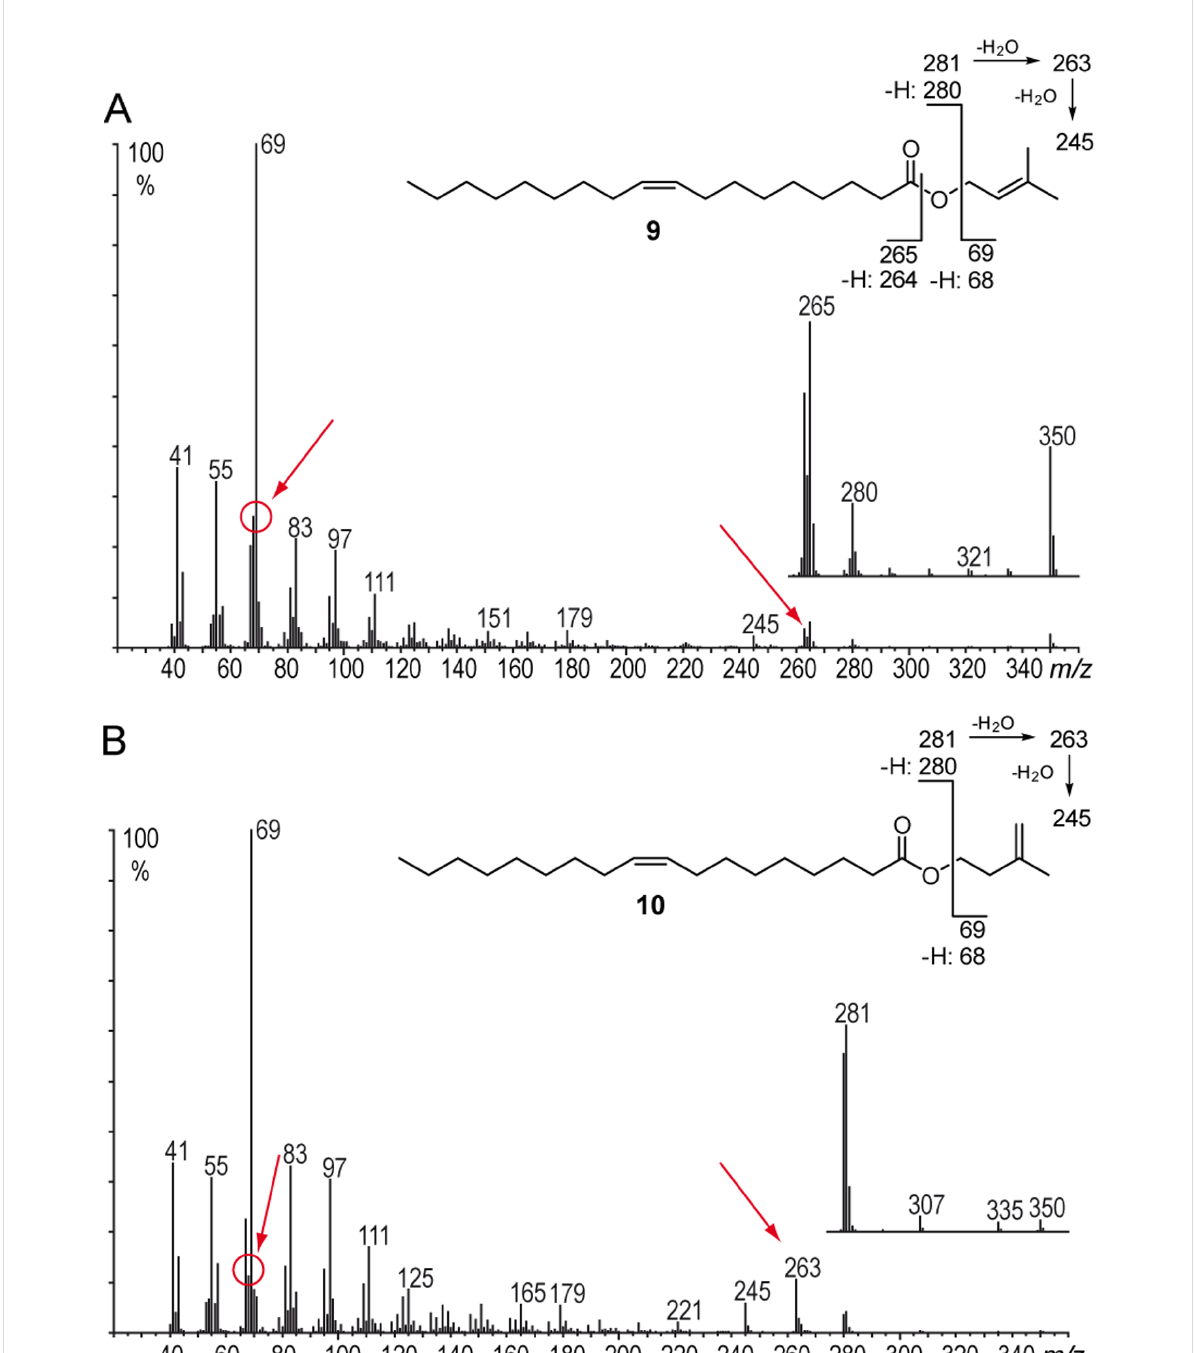
Figure 4: Mass spectra and fragmentation of A: isoprenyl (3-methyl-3-butenyl) 9-octadenoate ( 9 ) and B: prenyl (3-methyl-2-butenyl) 9-octadecenoate ( 10 ). Red arrows show characteristics in the mass spectra differentiating prenyl and isoprenyl esters.